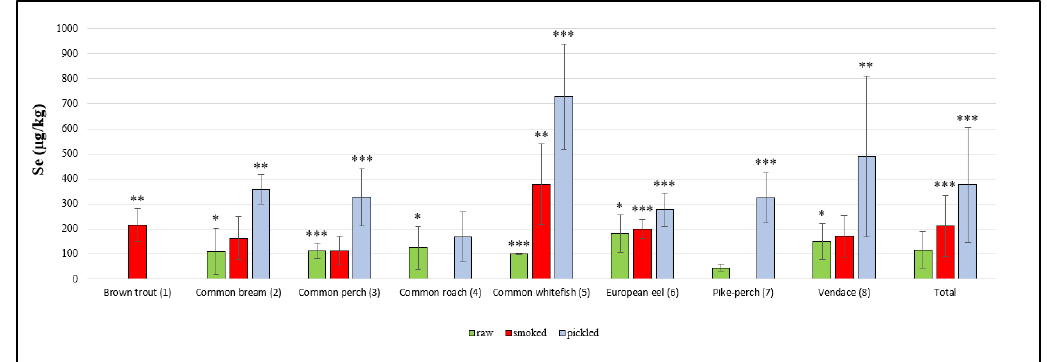
Figure 3. Se concentration in raw, smoked and pickled freshwater fish product samples (µg/kg). Statistical analysis showed significant differences in the Se content between species in each group of